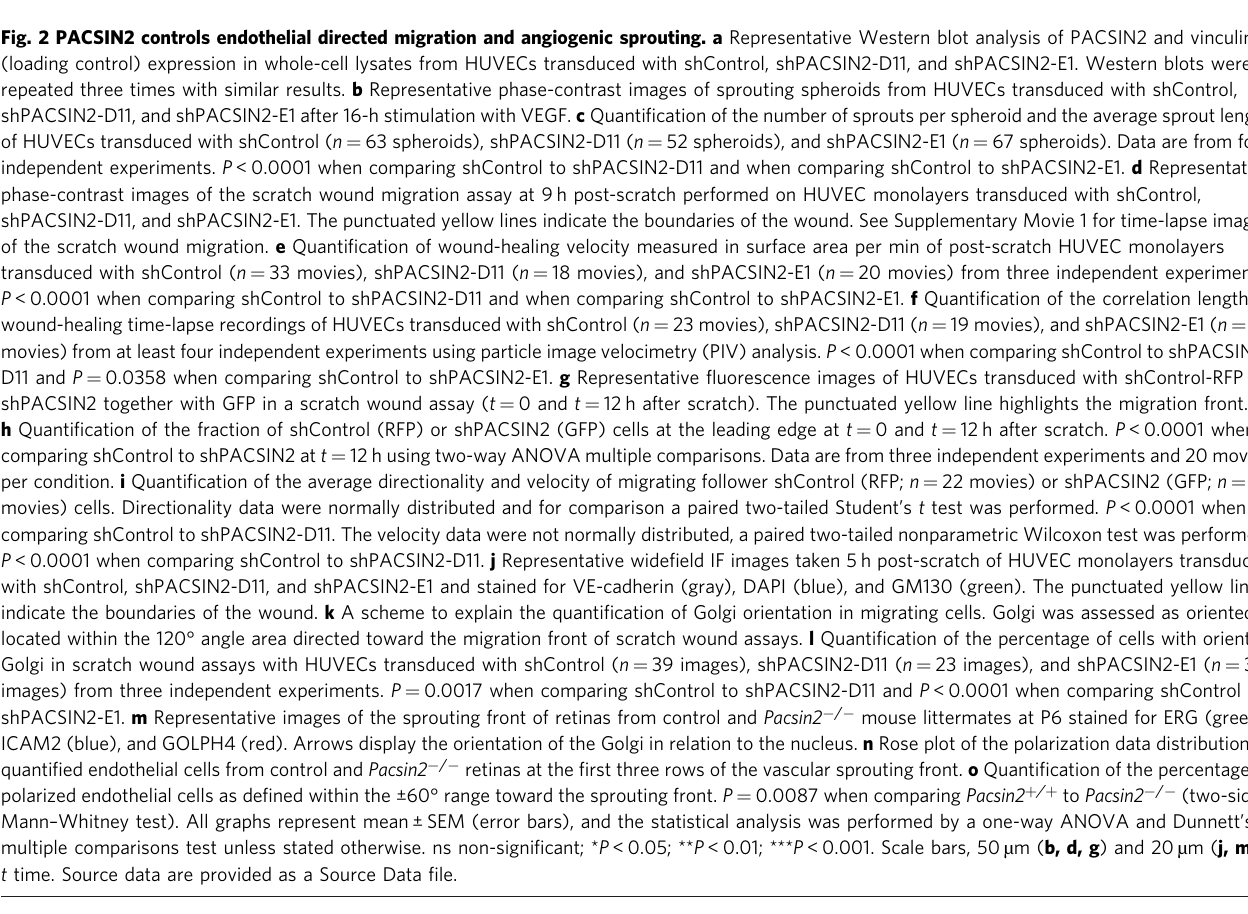
Fig. 2 PACSIN2 controls endothelial directed migration and angiogenic sprouting. a Representative Western blot analysis of PACSIN2 and vinculin (loading control) expression in whole-cell lysates from HUVECs transduced with shControl, shPACSIN2-D11, and shPACSIN2-E1. Western blots were repeated three times with similar results. b Representative phase-contrast images of sprouting spheroids from HUVECs transduced with shControl, shPACSIN2-D11, and shPACSIN2-E1 after 16-h stimulation with VEGF. c Quanti fi cation of the number of sprouts per spheroid and the average sprout length of HUVECs transduced with shControl ( n = 63 spheroids), shPACSIN2-D11 ( n = 52 spheroids), and shPACSIN2-E1 ( n = 67 spheroids). Data are from